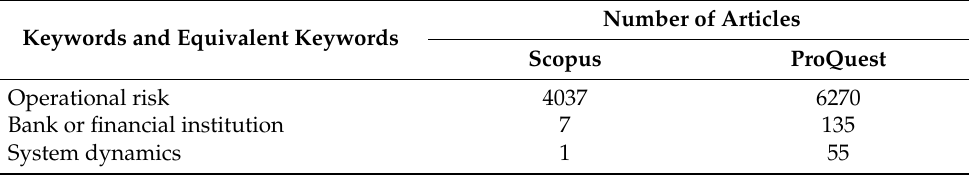
Table 3. Number of banking operational risk management studies applying system dynamics identified from a systematic literature